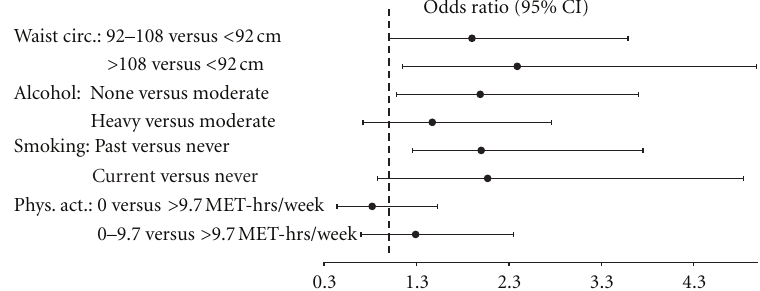
Figure 2: Forest plot of odds-ratios and 95% confidence intervals for the e ff ect of each health behaviour on endothelial dysfunction adjusting for covariates and the other health